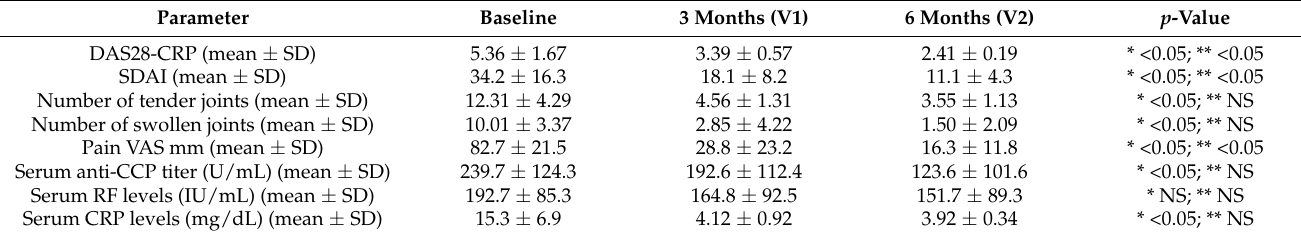
Table 2. Changes in rheumatoid arthritis (RA)-related parameters at 3 and 6 months after tocilizumab.